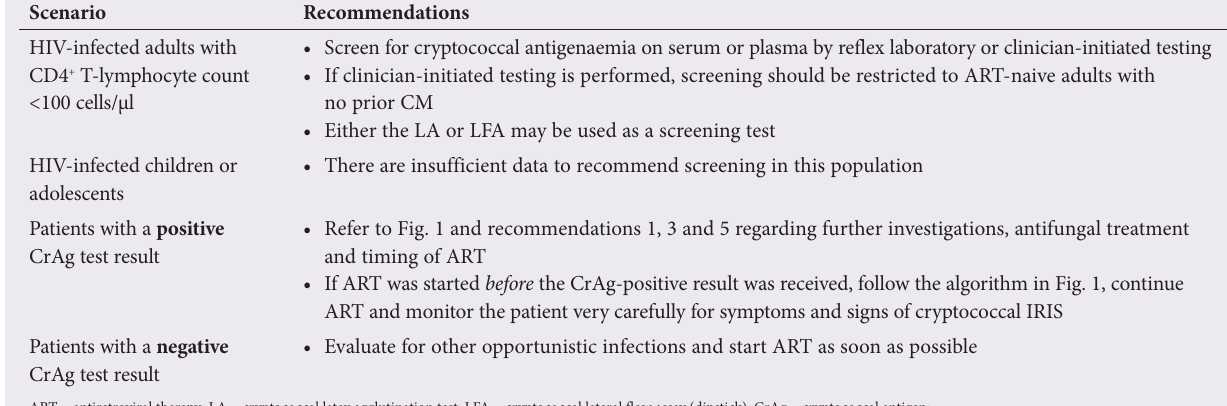
Table 1. Summary of recommendation 1: Screening and pre-emptive treatment Scenario Recommendations